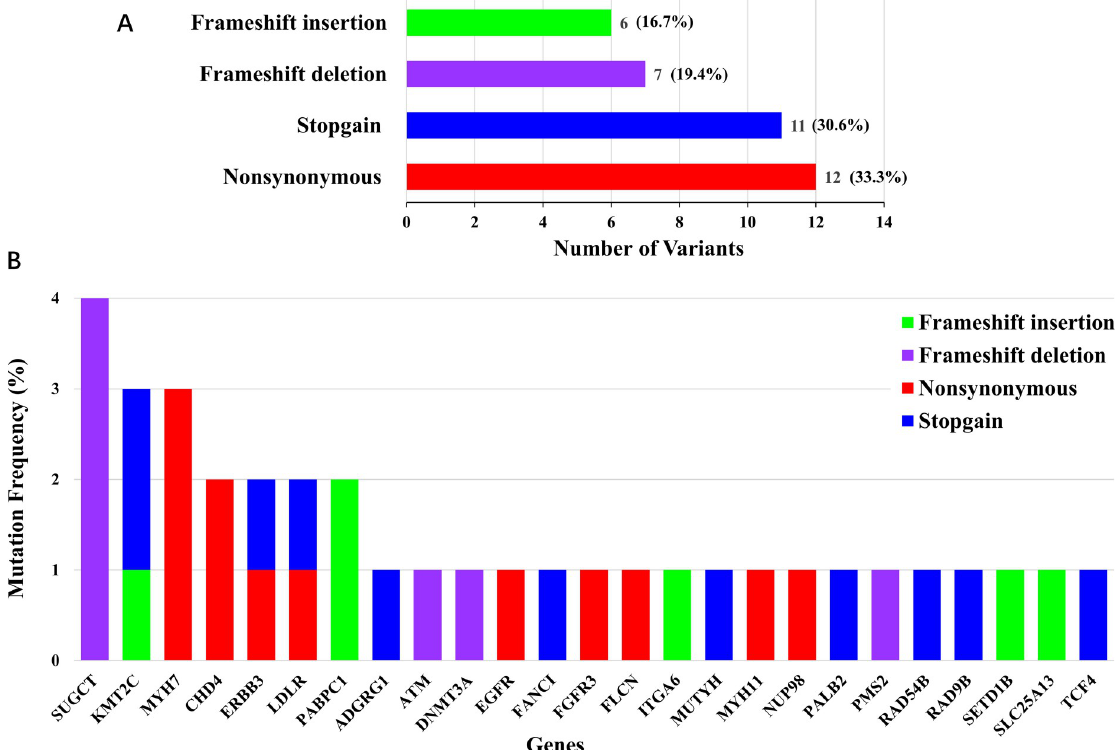
Fig 3. Mutation frequency of deleterious variants and genes. ( A ) The number and frequency of each mutation type among 36 deleterious variants. ( B ) The mutation frequency of 25 deleterious germline genes. Genes are ordered by frequency, and mutations are stratified by mutation